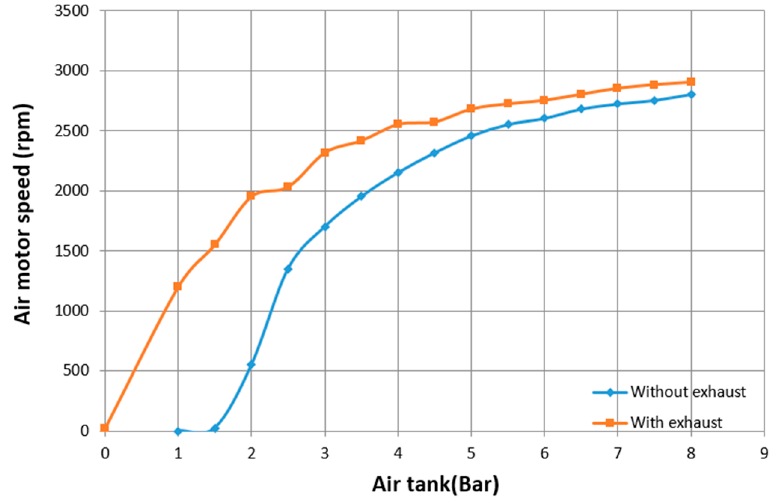
Figure 8. Relationship between air motor speed and inlet pressure in case of with and without exhaust at the free load condition.